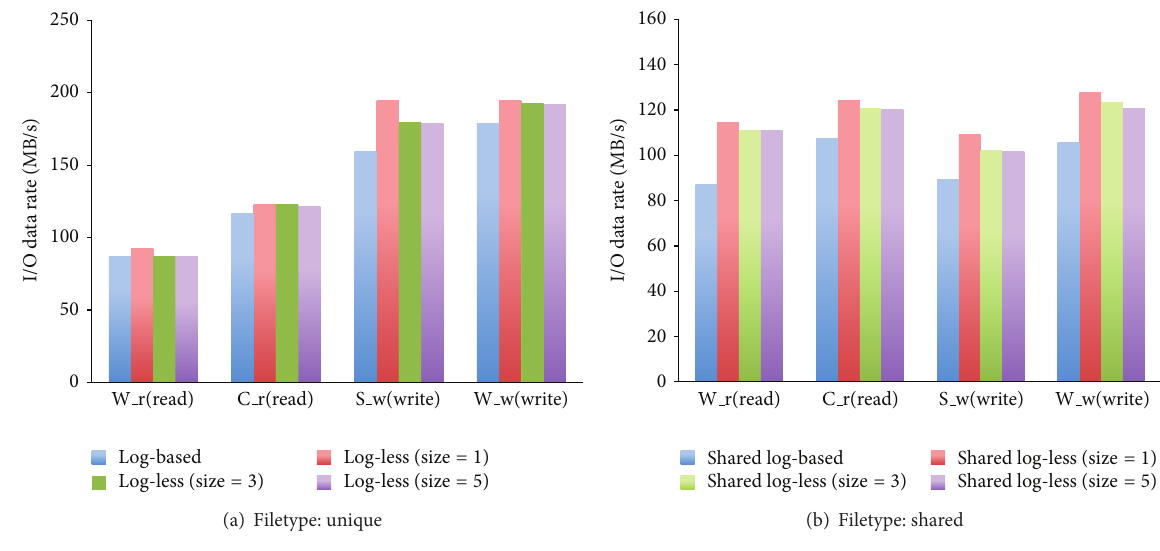
Figure 7: MADbench2 results: IOMETHOD = MPI, SYNC, 18KPIX,